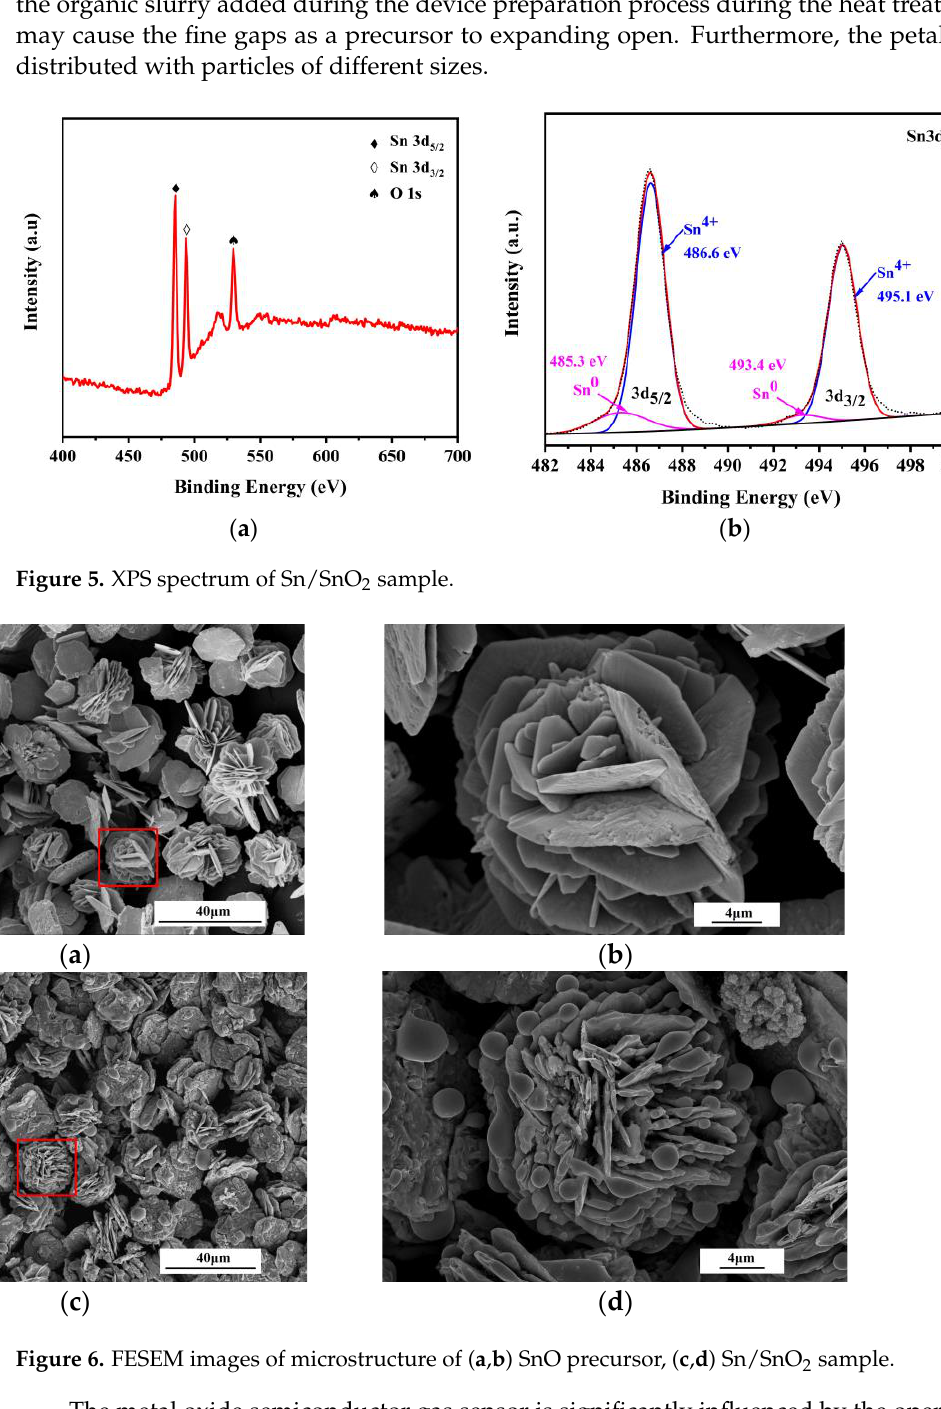
Figure 5. XPS spectrum of Sn/SnO 2 sample.